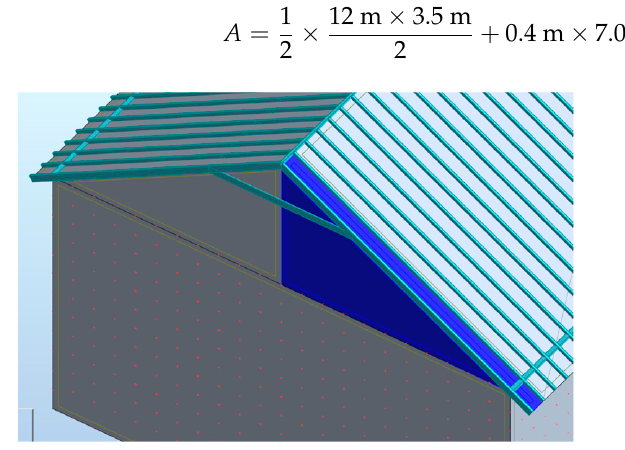
Figure 14. Area of projected area.